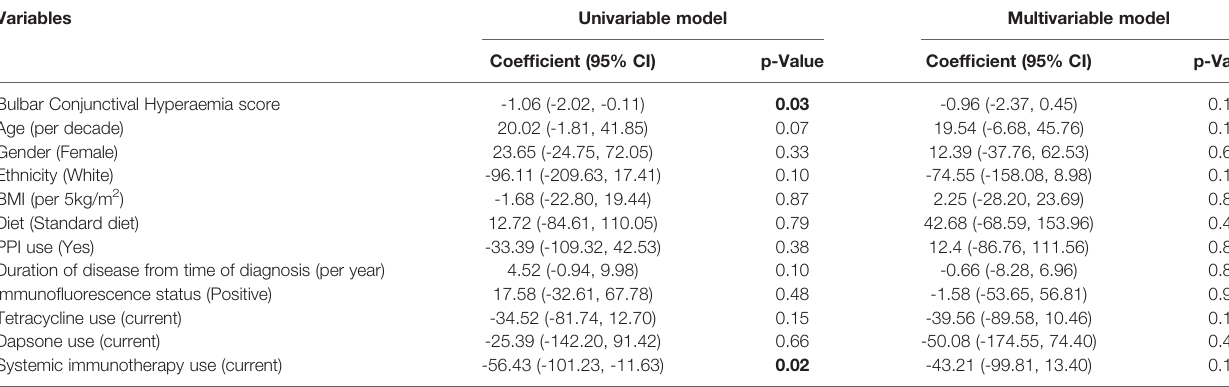
TABLE 5 | Linear regression models of number of OTUs and ocular in fl ammation